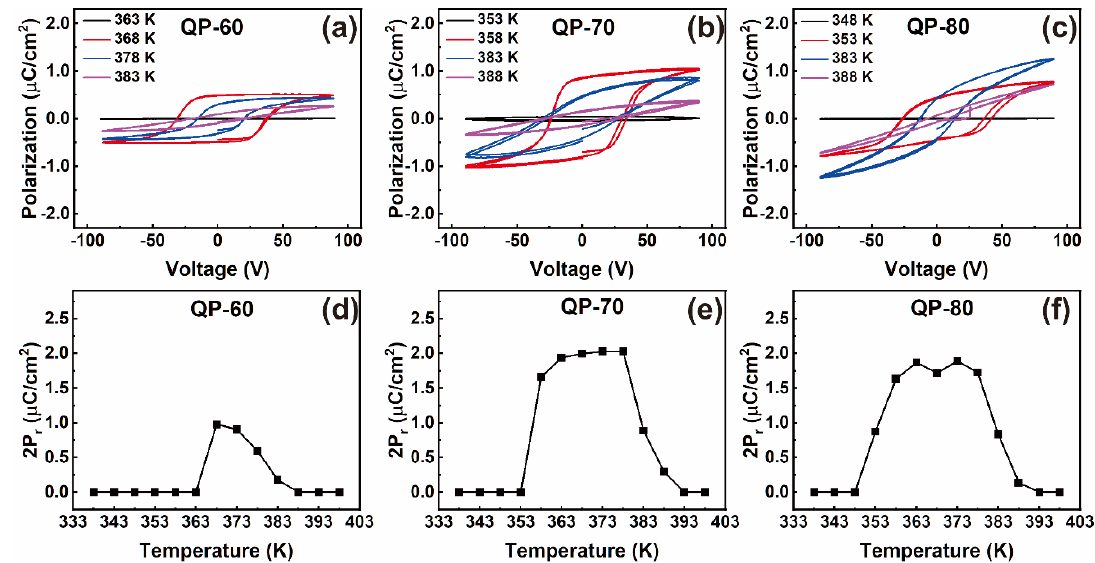
Figure 3. ( a – c ) The temperature-dependent P-V loops and ( d – f ) variation of 2 P r values with the temperature of QP-60, QP-70, and QP-80 capacitors.